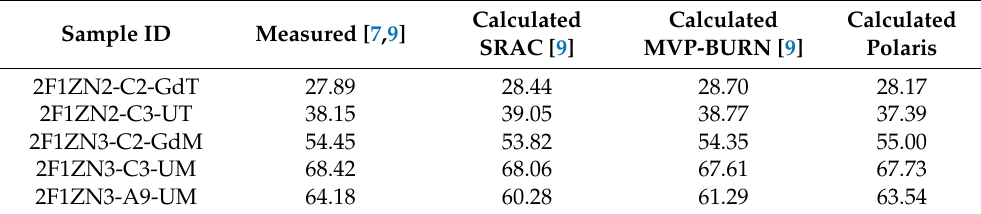
Table 2. Sample burnup comparison (in